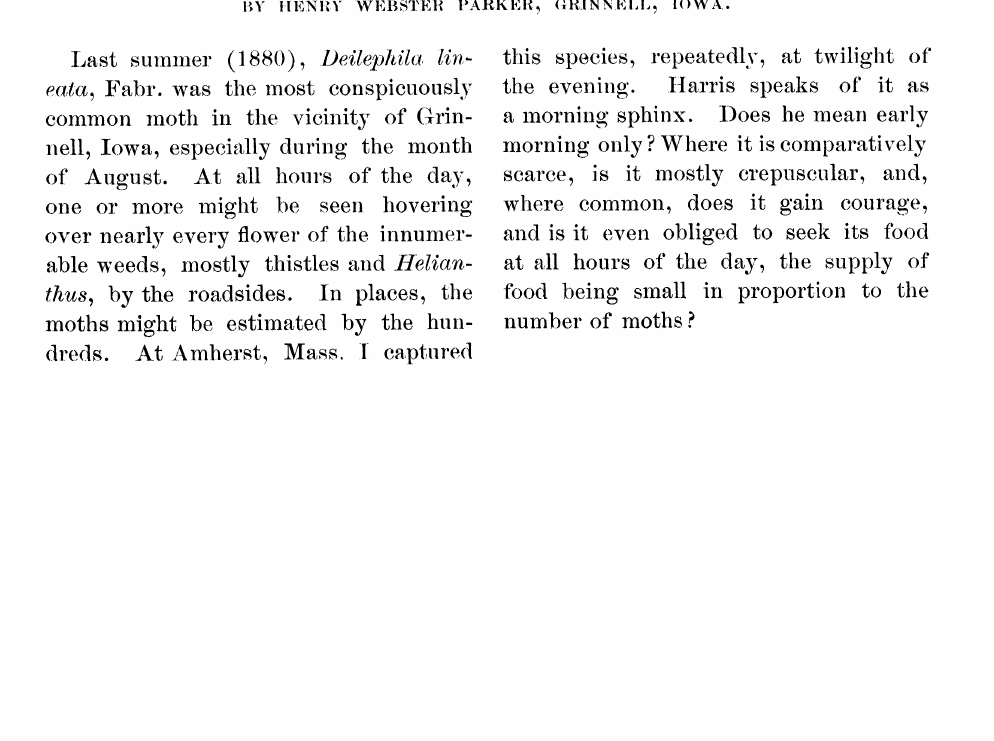
Fig. 7.--Pupa of Catog’enus rufus, a, ventral view. b, dorsal view. fig. 7, was that of a coleopteron, and from it emerged, about July, Catogenus The pupa of Elaphidion was 15.5